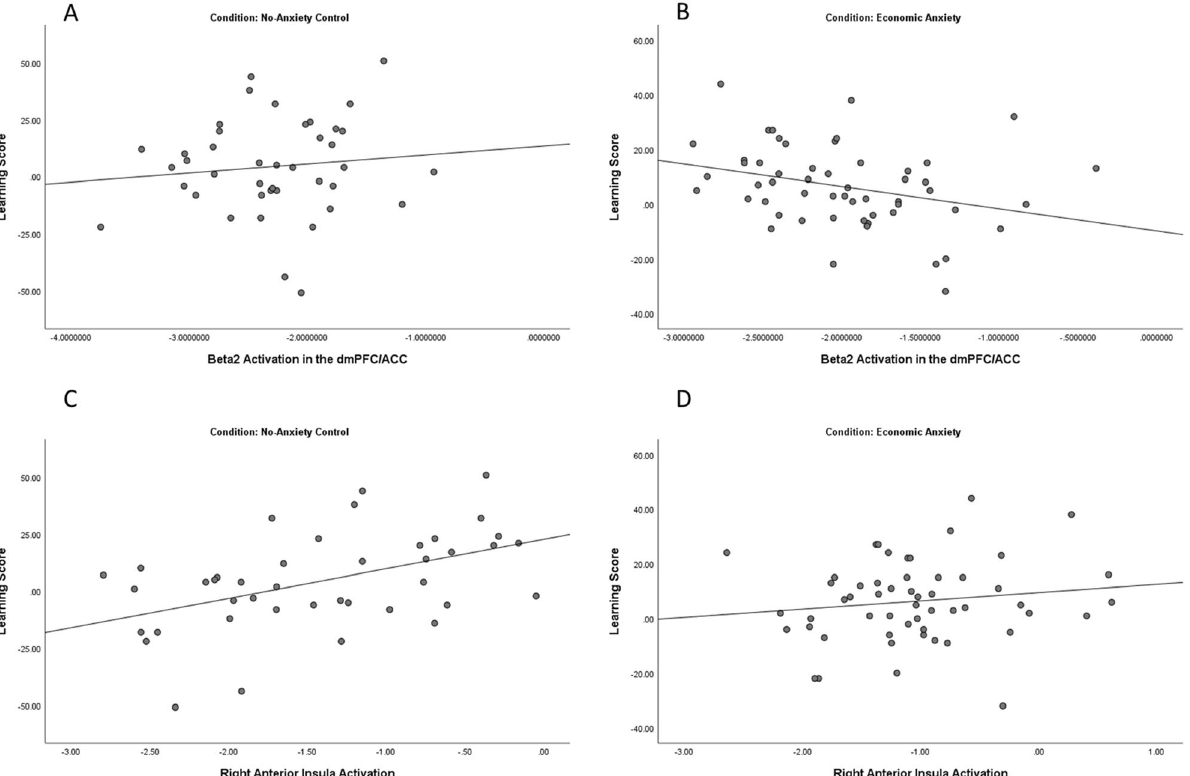
Figure 3. Scatterplots showing correlations between anxiety-specific activation and the learning score in the different conditions. Beta2 activation in the dmPFC/ACC in ( A ). the No-Anxiety Control condition, r = 0.111, p = 0.489, and ( B ) the Economic Anxiety Condition, r = − 0.305, p = 0.025 Right Anterior Insula Activation in ( C ) the No-Anxiety Control condition, r = 0.474, p = 0.002, and ( D ) the Economic Anxiety Condition, r = 0.142, p =